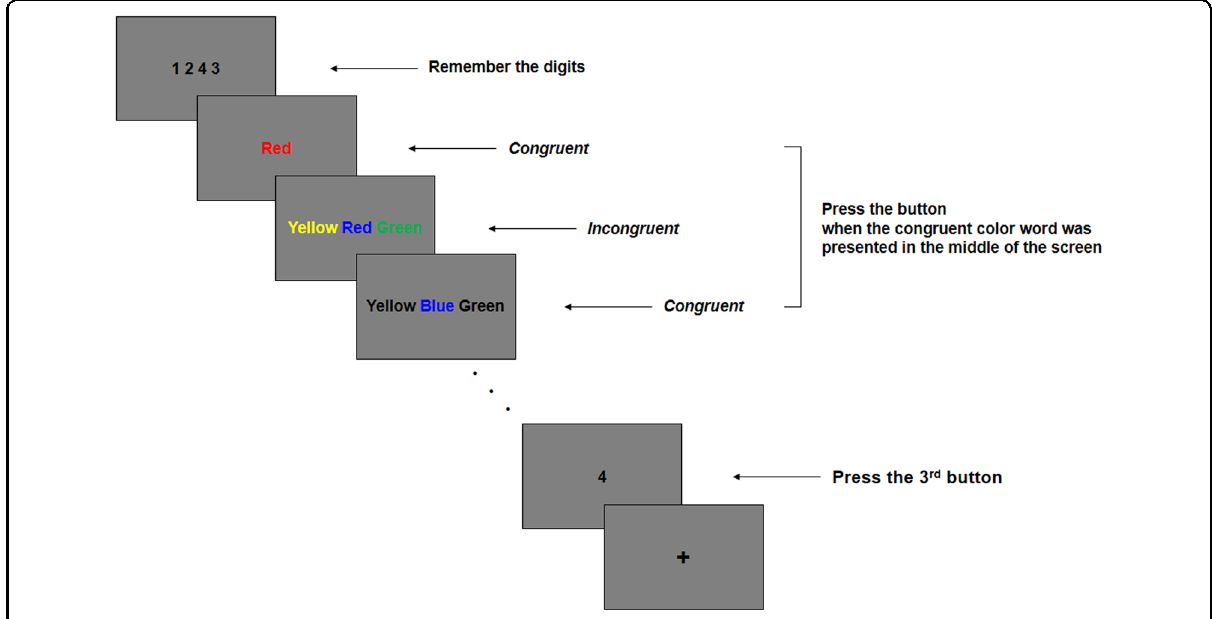
Fig. 1 Illustration of the experimental task. We modi fi ed the traditional Stroop color-word task and Eriksen fl anker task to examine the effect of distractor interference on attentional control. The target word was presented in the middle of the screen, and the participants were instructed to press a button when the printed color and meaning of the target word were congruent, regardless of the distractor words fl anked on either side of the target word. Furthermore, it consisted of a study phase in which four digits (ranging from 1 to 4) to be remembered were presented for 1.5 s with a 100-ms blank screen before each experimental block started and a test phase in which the participant was asked to press the button corresponding to the order of the presented number previously shown in the study